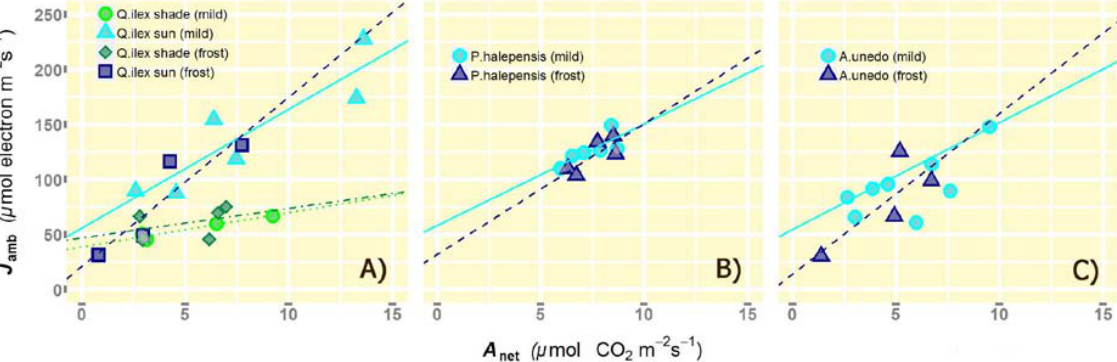
3 Figure 10. Relationship between the rate electron transport from chlorophyllic fluorescence ( J amb ) and net assimilation ( A net ) at ambient CO 2 concentrations and saturating light ( A net ) in (a) Q. ilex , (b) P. halepensis and (c) A. unedo leaves. Leaves measured under mild conditions are indicated by green circles and cyan triangles in shaded and sunlit locations, respectively. Leaves measured after the period of frost are indicated by green diamonds and blue squares in shaded and sunlit locations,